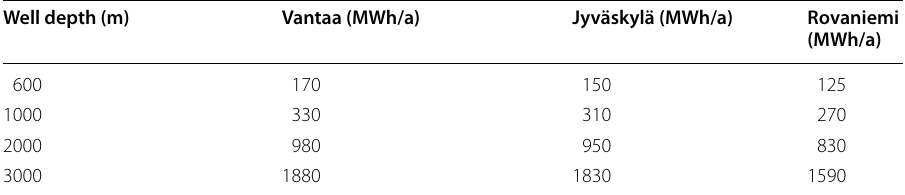
Table 3 Maximum thermal energy production (MWh/a) from three locations with VIT pipe and a flow rate of 3 L/s with a 600-m-deep well and 5L/s with well depths of 1000 m, 2000 m, and 3000 m Well depth